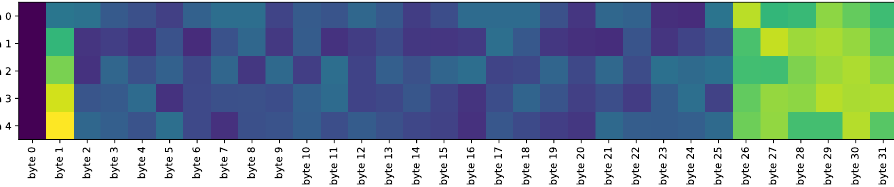
Block of binary data aligned and reshaped.